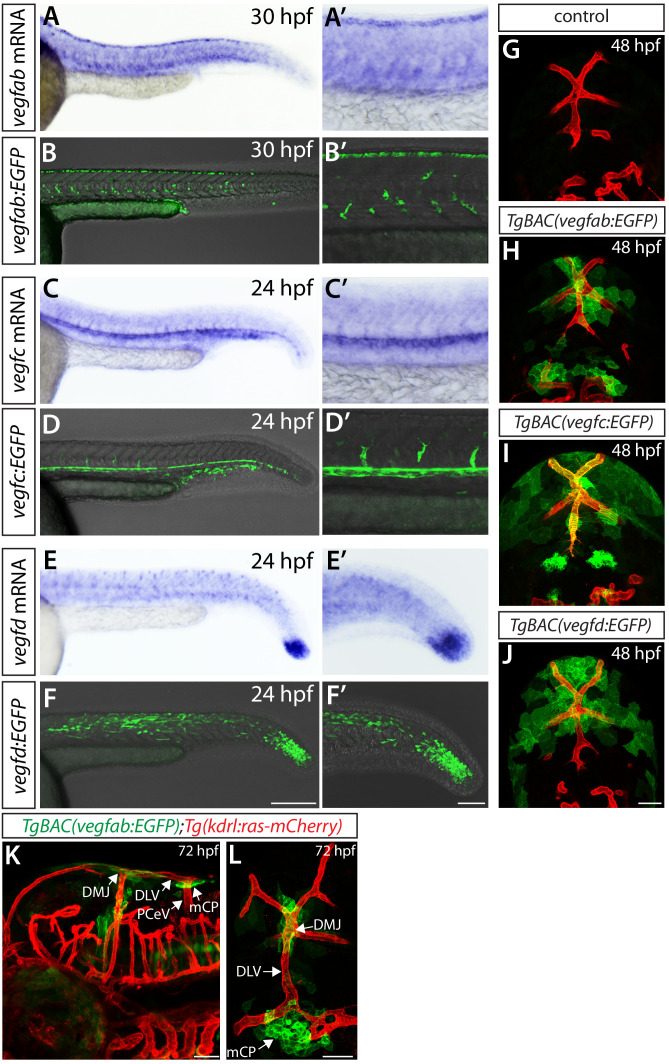
Validation and expression analyses of distinct vegf BAC transgenic lines.(A–F’) Endogenous mRNA transcripts of vegfab (A and A’), vegfc (C and C’), and vegfd (E and E’) at the indicated embryonic stages were detected by in situ hybridization. Lateral views of the EGFP expression patterns driven by the Tg(UAS:EGFP) embryo carrying the TgBAC(vegfab:gal4ff) (B and B’), TgBAC(vegfc:gal4ff) (D and D’), or TgBAC(vegfd:gal4ff) (F and F’) transgene. The EGFP expression patterns driven by each of the BAC transgenic lines closely matched those of the corresponding endogenous mRNA. (G–J) Dorsal views of 48 hpf Tg(kdrl:ras-mCherry) embryos with no additional gene (G) or carrying the TgBAC(vegfab:EGFP) (H), TgBAC(vegc:EGFP) (I), or TgBAC(vegd:EGFP) (J) transgene. No detectable auto-fluorescence was observed in the control embryo (G) under these microscopy settings. TgBAC(vegfab:EGFP), TgBAC(vegfc:EGFP), and TgBAC(vegfd:EGFP) expression was observed in dorsal meningeal surfaces and distinct cell types. (K and L) Lateral (K) and dorsal (L) views of 72 hpf TgBAC(vegfab:EGFP);Tg(kdrl:ras-mCherry) larvae, showing the TgBAC(vegfab:EGFP) expression in the DMJ and mCP. TgBAC(vegfab:EGFP) expression was not observed in the DLV. Scale bars: 200 μm in (F); 100 μm in (F’); 50 μm in (J), (K), (L).